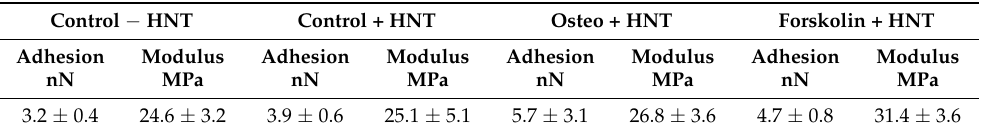
Table 2. Mechanical characteristics of MSC monolayer (scan area 30 × 30 µ m) of cells after cultivation under osteogenic (osteo) and non-osteogenic conditions (control).